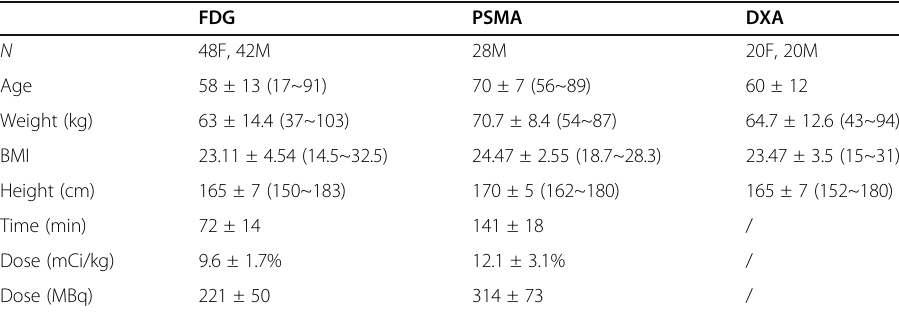
Table 1 Characteristics of recruited